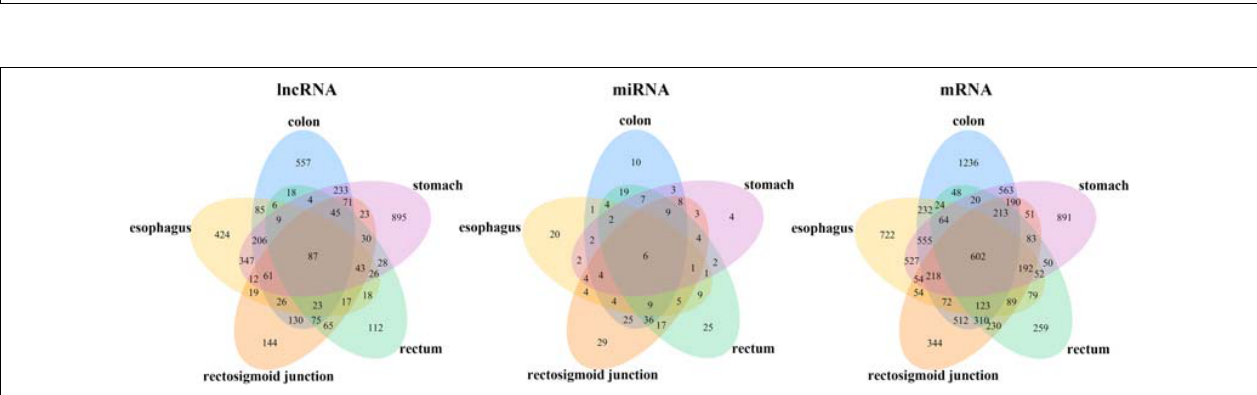
FIGURE 1 | Volcano plots of DEmRNAs, DEmiRNAs and DElncRNAs in five cancers. The volcano map of differentially expressed lncRNAs (top), miRNAs (middle), and mRNAs (bottom). Red and blue spots represent significant up- and down-regulated RNAs, respectively. The remark for the gene symbols represent the significant up- and down-regulated RNAs.